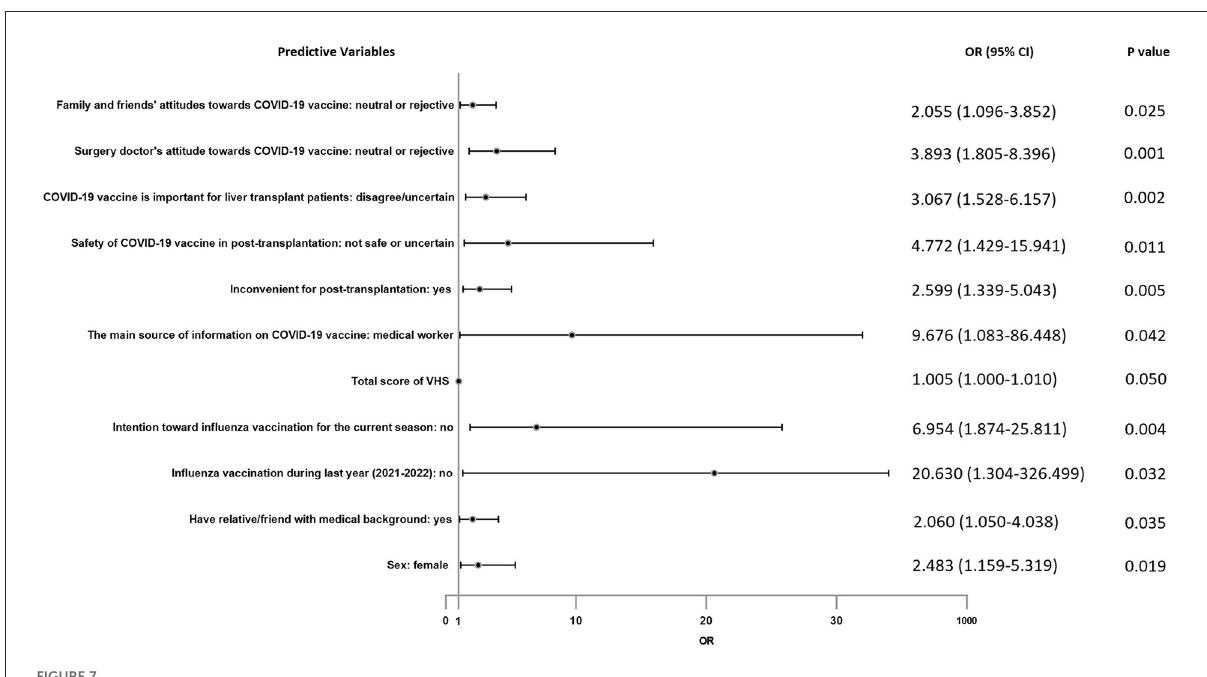
FIGURE7 Forest plot of predictors for vaccine